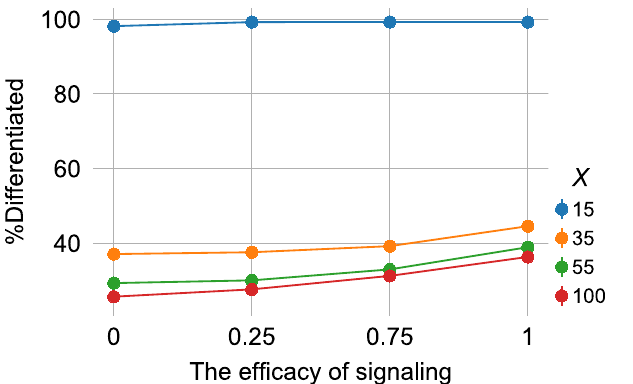
Fig 4. Adding signaling to the cell aggregation model results in higher none-genetic phenotypic diversity, compared to populations without signaling (as shown in Fig 5). The phenotypic diversity is represented by the proportion of cells with the phenotype B relative to the total number of cells in the population. The curves indicate different amounts of protein X in the mother cell. It fascinating to notice how the lowest number of TFs ( X = 10) results in total differentiation. The efficacy of signaling is defined as follows: if in the position of a cell with phenotype A , the signal concentration exceeds the mean signal concentration, then this cell would have more chance of becoming a B cell. The results are average over 100 replications. Error bars are 95%CI. The error bars are too small to be seen.